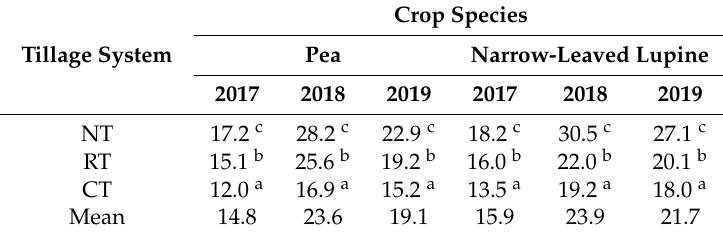
Table 2. Dry weight of weeds (g · m − 2 ) in di ff erent tillage system in the flowering stage in 2017–2019.